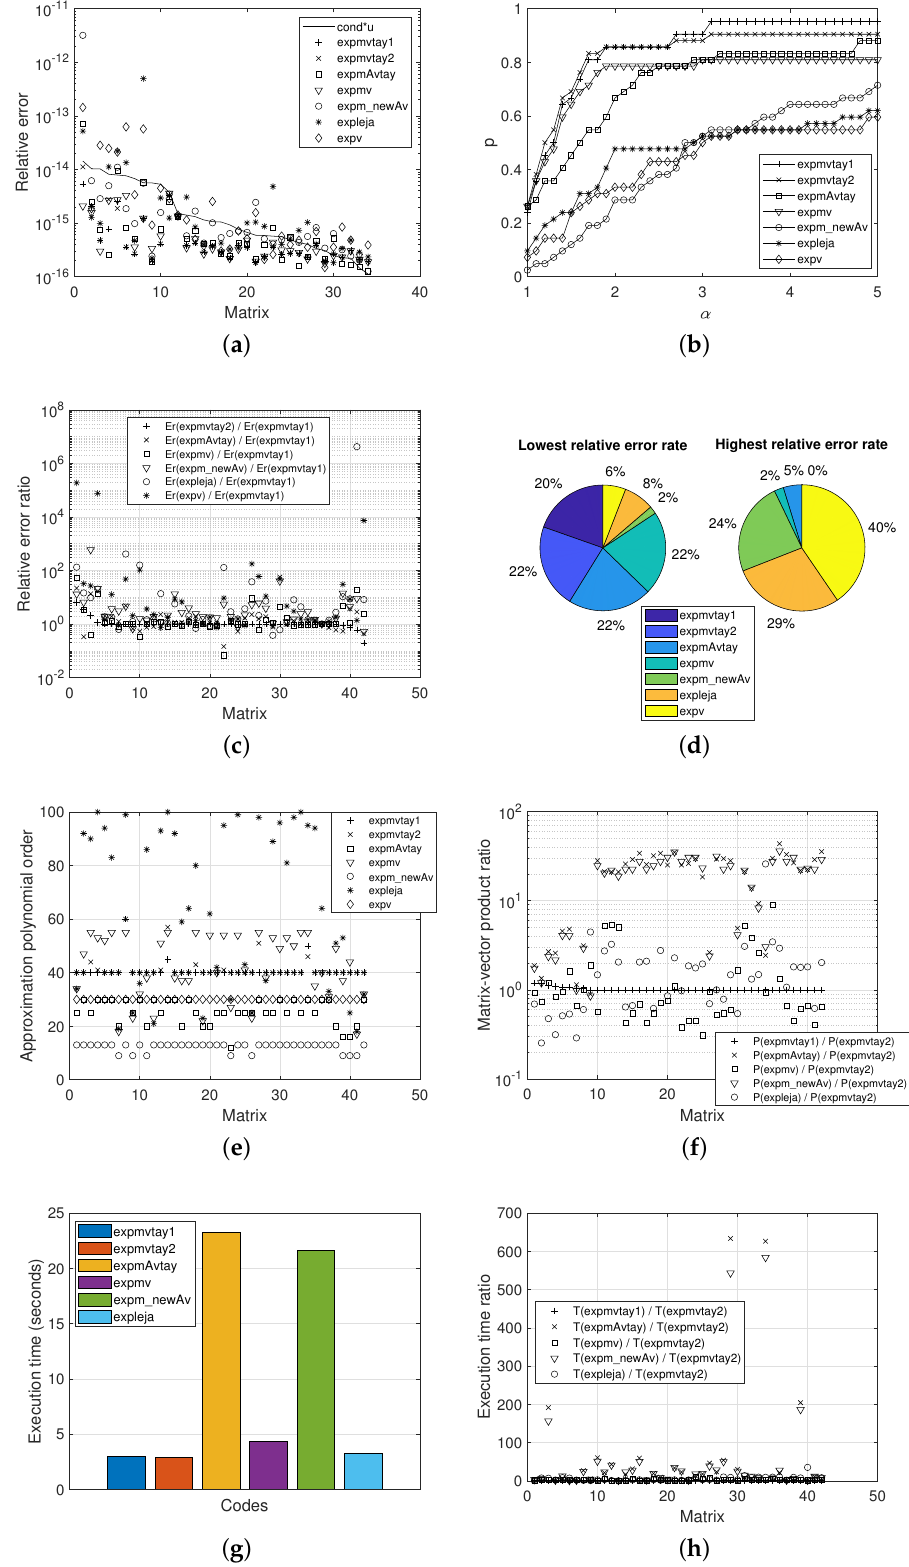
Figure 3. Experimental results for Set 3. ( a ) Normwise relative errors. ( b ) Performance profile. ( c ) Ratio of relative errors. ( d ) Lowest and highest relative error rate. ( e ) Polynomial, interpolation and subspace orders. ( f ) Ratio of matrix–vector products. ( g ) Execution time. ( h ) Ratio of execution